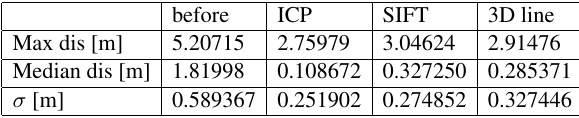
Table 3. Comparison of TIR point cloud and RGB point cloud before and after coregistration the 3D point clouds (ICP), the im- age blocks (SIFT), or the 3D line segments of the RGB model and 2D line segments of TIR images (3D line).